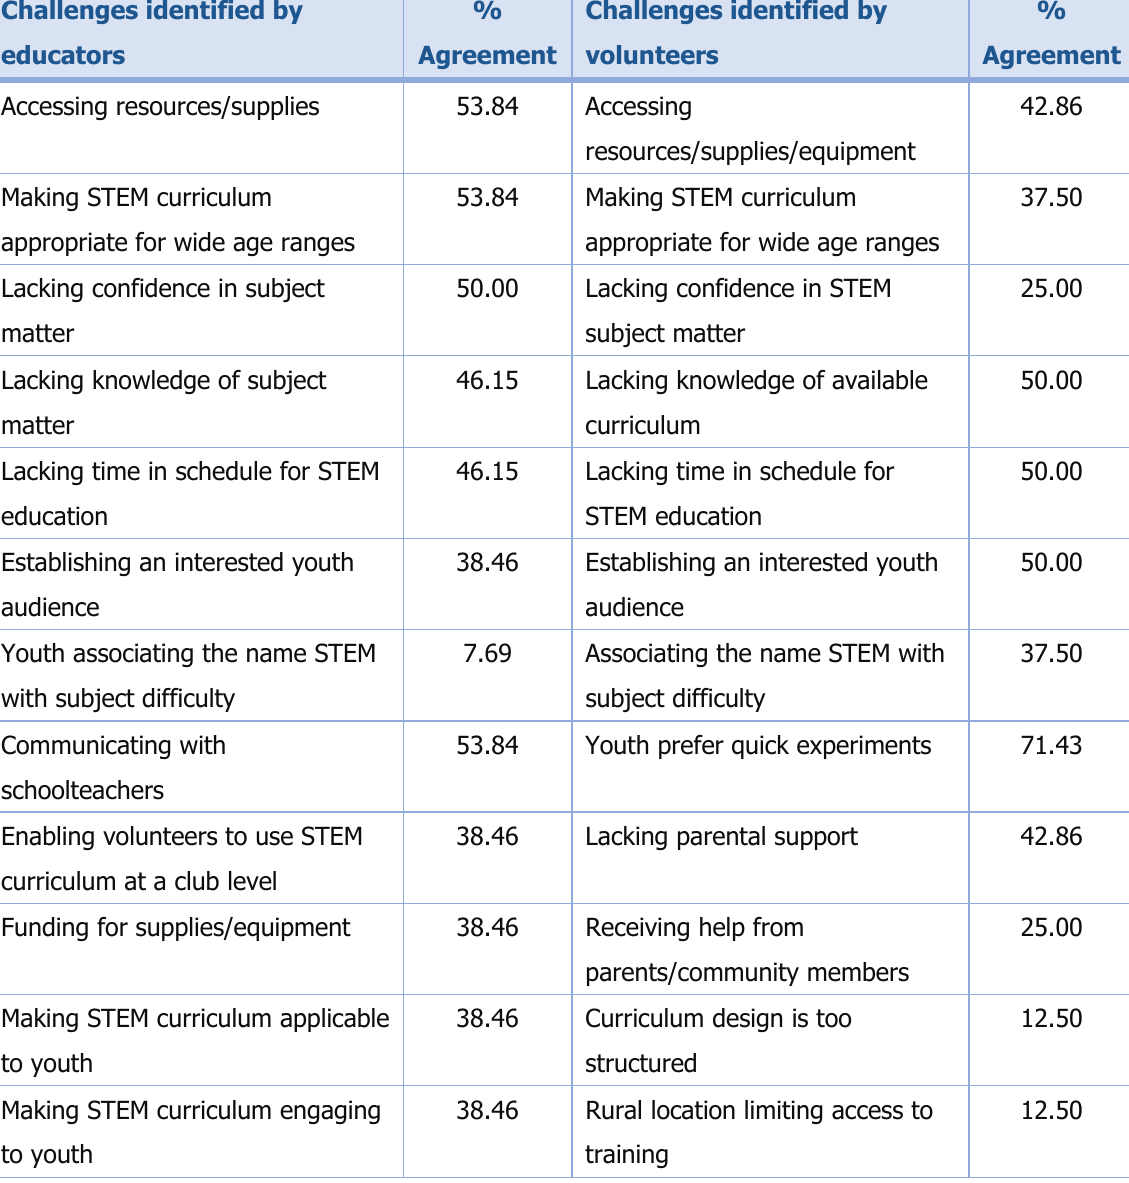
Table 6. Comparison of Perceived Challenges Identified by the Panels Not Reaching